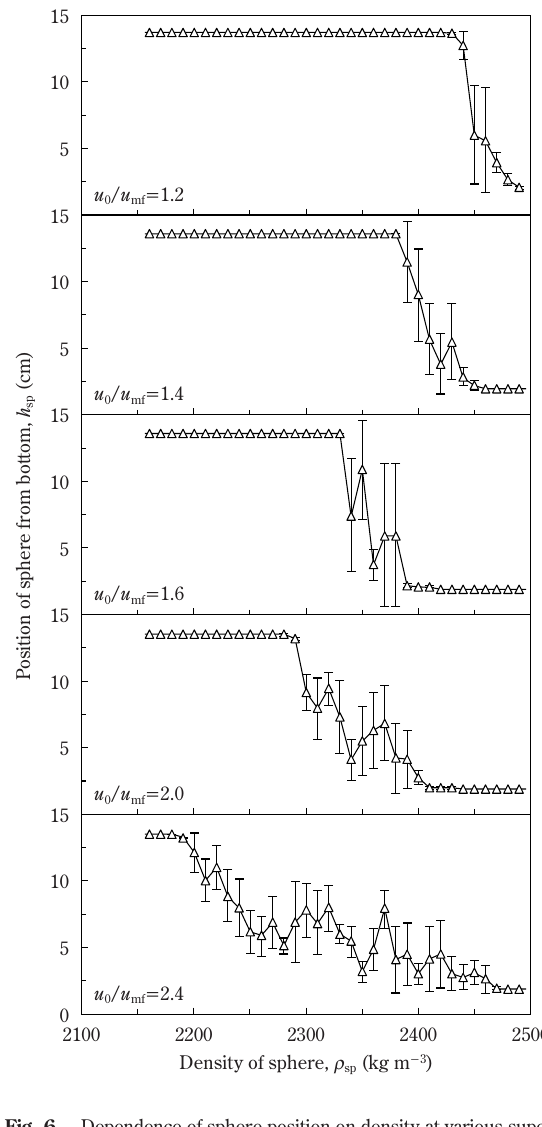
Fig. 6 Dependence of sphere position on density at various super- ficial velocities. Powder is zircon sand.